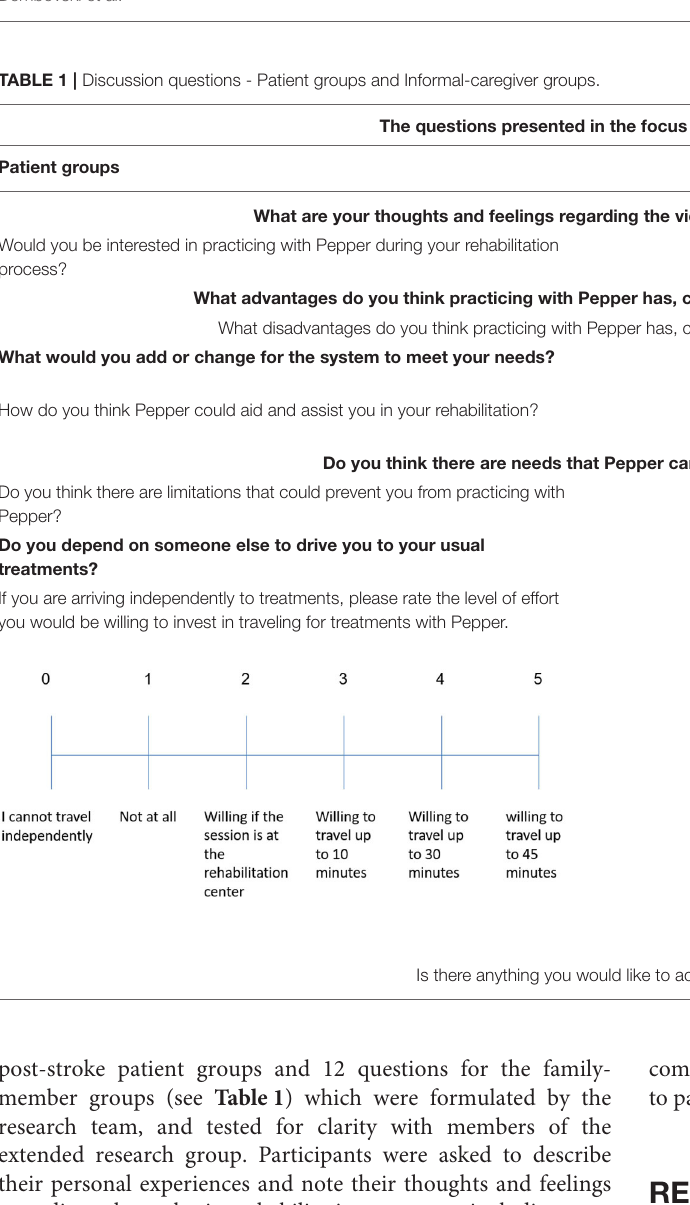
Table 2 ). Three focus groups were held in three different